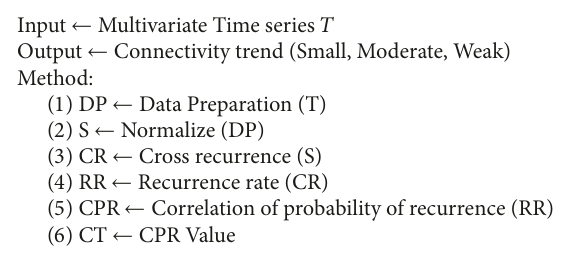
Algorithm 1: Recurrence based similarity